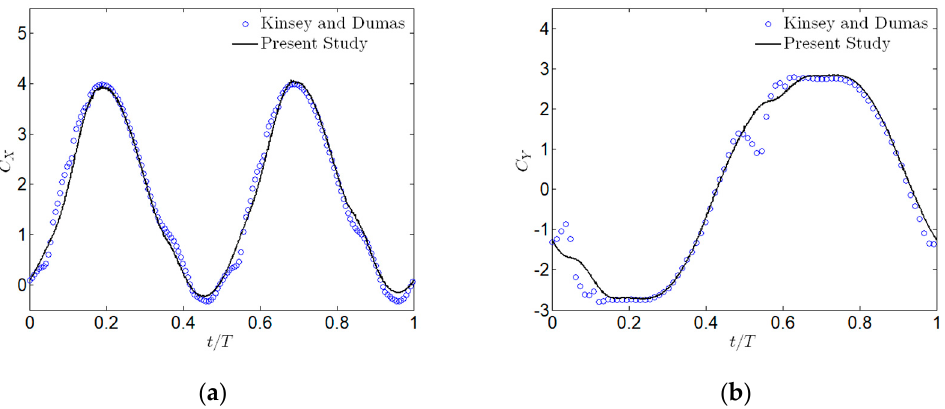
Figure 3. Comparison of results by the present study and Kinsey and Dumas for y 0 = 1 c , θ 0 = 70 o , f ∗ = 0.14, ( a ) thrust coe ffi cient and ( b ) lift coe ffi cient. Table 2. Main characteristics for computations.